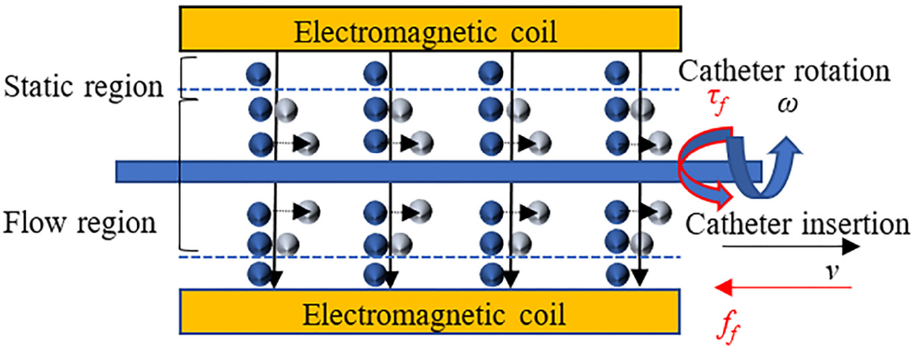
Figure 3. Schematic diagram of force feedback generation.